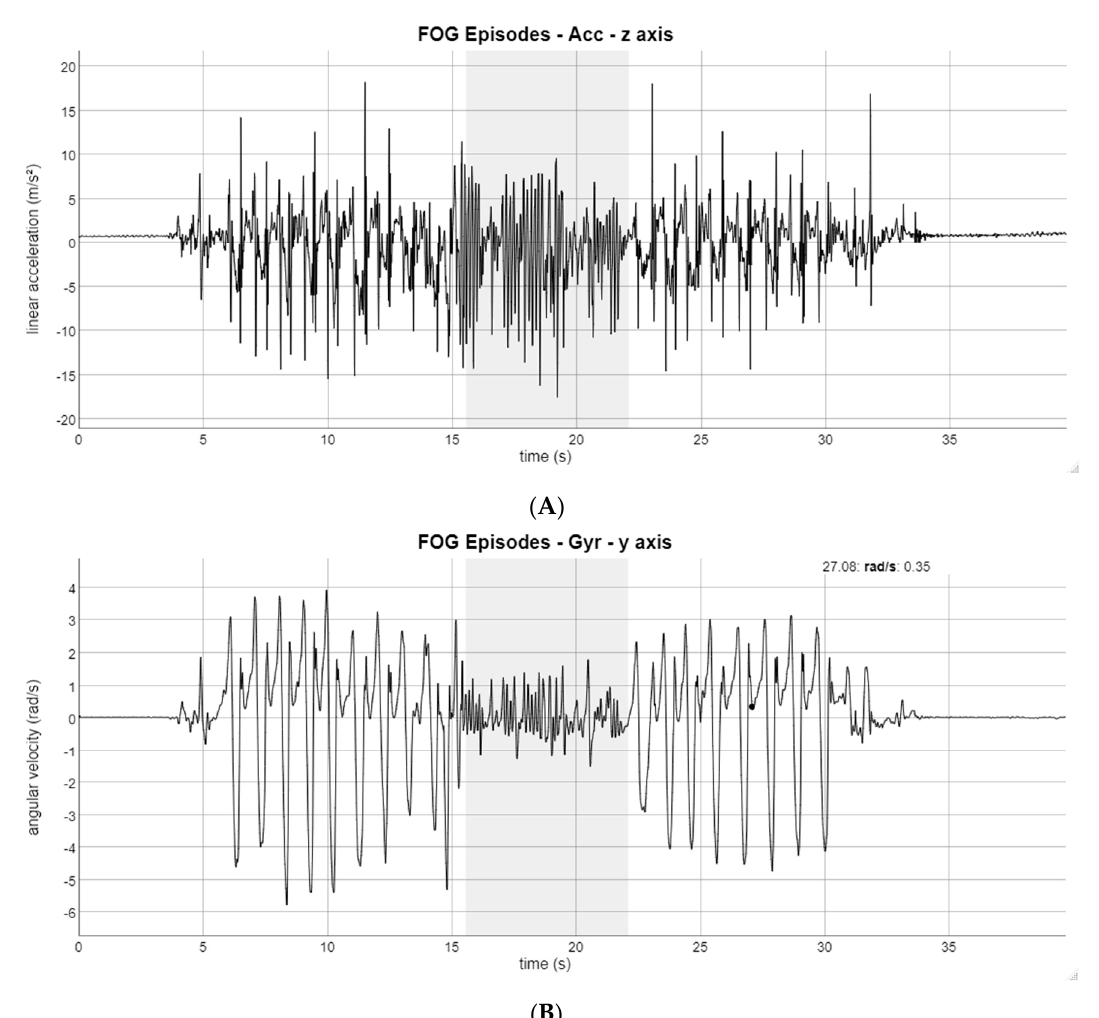
Figure 5. Example of a FOG episode shadowed in gray detected by the sensor placed on the volunteer’s most affected calf. Subfigures ( A , B ) represent the waveform of the inertial signal during the TUG test ( A ) Linear acceleration in the z axis of the accelerometer ( B ) Angular velocity in the y axis of the gyroscope.